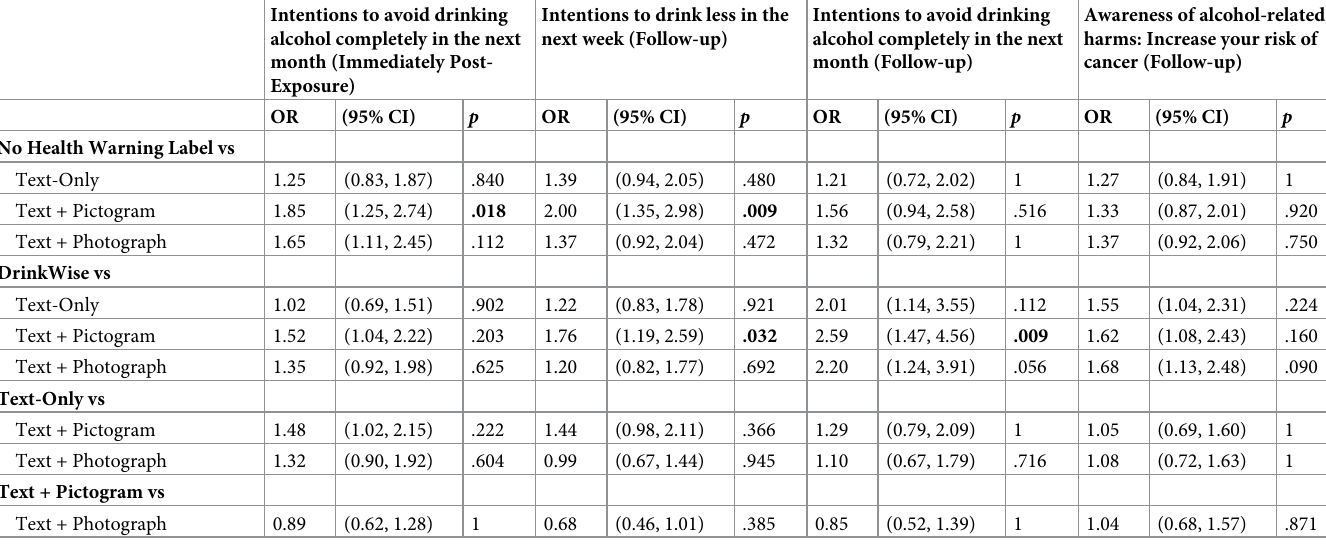
Table 3. Pairwise comparisons for intention and knowledge outcomes for which there was a significant omnibus test. Intentions to avoid drinking alcohol completely in the next month (Immediately Post-